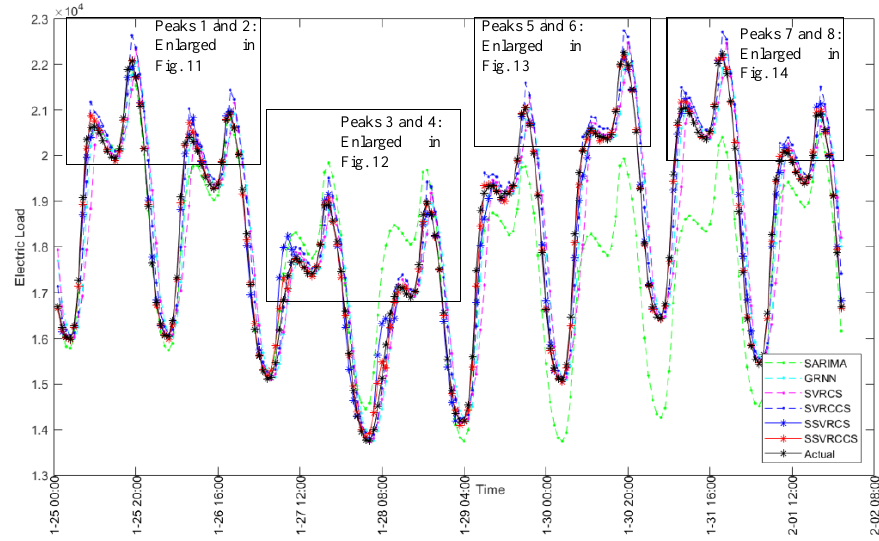
Figure 10. Forecasting values of SVR with chaotic cuckoo search (SSVRCCS) model and other alternative models for Example 2. Energies 2018 , 11 , x